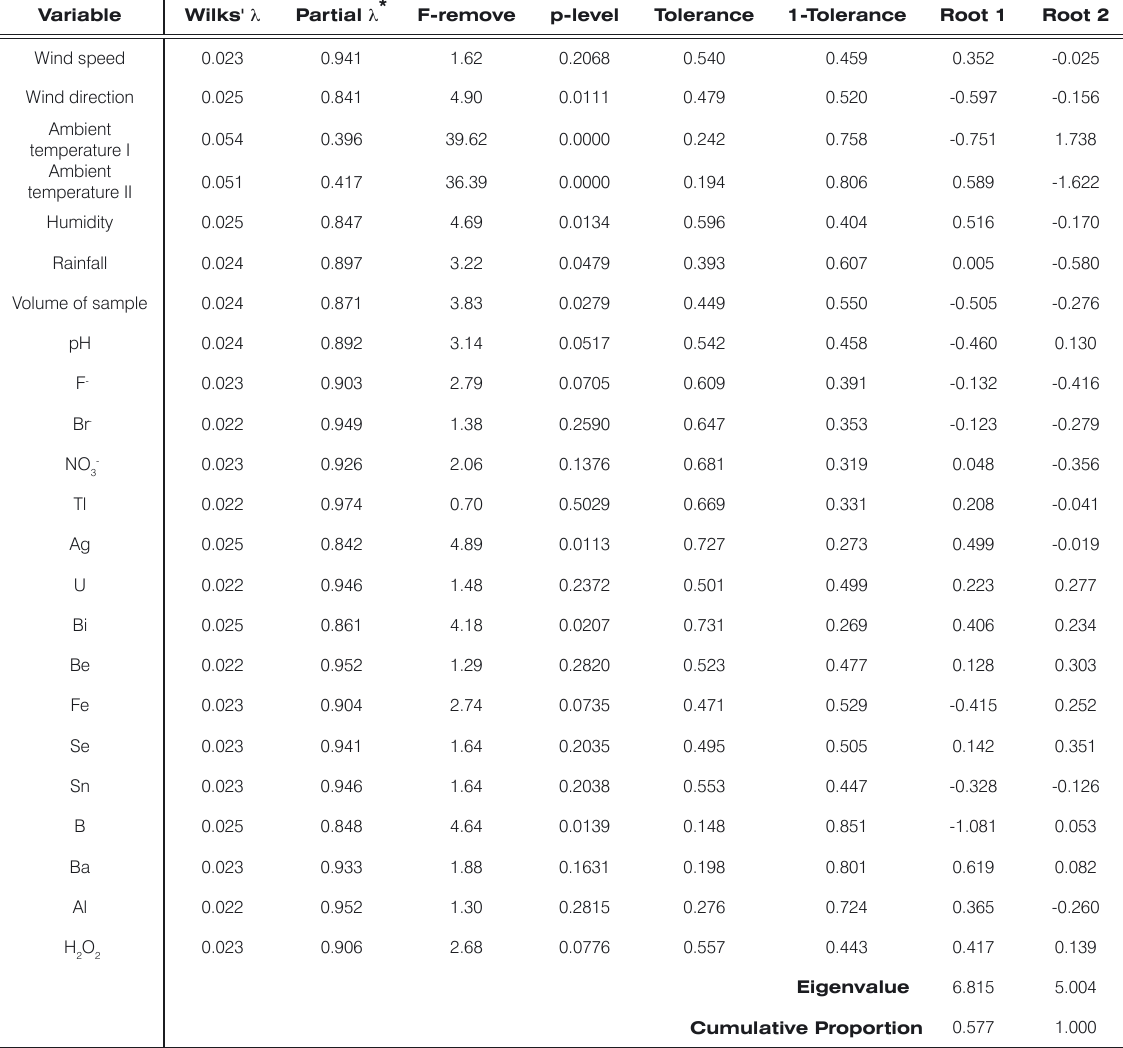
Table 6. Variables in the model (Gdansk, Mława, Krakow) and the standardized canonical discriminant function coefficients